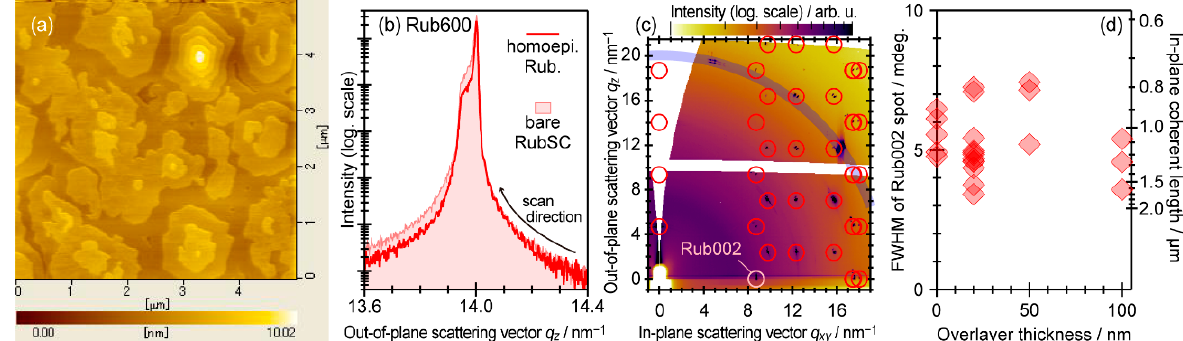
Figure 12. ( a ) AFM topography of a RubSC sample covered with 20 nm-thick homoepitaxial rubrene. Cited from [107]. ( b ) Out-of-plane diffraction spot profiles of a RubSC sample covered with 20 nm-thick homoepitaxial rubrene (red line) and a bare RubSC sample (light-red shaded). ( c ) Azimuthally integrated 2D-GIXD image of 100 nm-thick homoepitaxial rubrene on a RubSC sample. Simulated diffraction patterns for the RubSC (100) surface and Si (powder) are overlaid as red circles and a blue thick arc. ( d ) FWHM of the Rub002 diffraction spots plotted as a function of the homoepitaxial rubrene thickness. The right axis displays the corresponding coherent length for reference. The viewgraph ( d ) is cited from [31] (CC-BY).